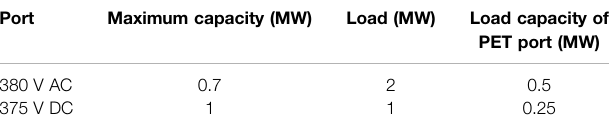
TABLE 3 | PET port capacity and load capacity.